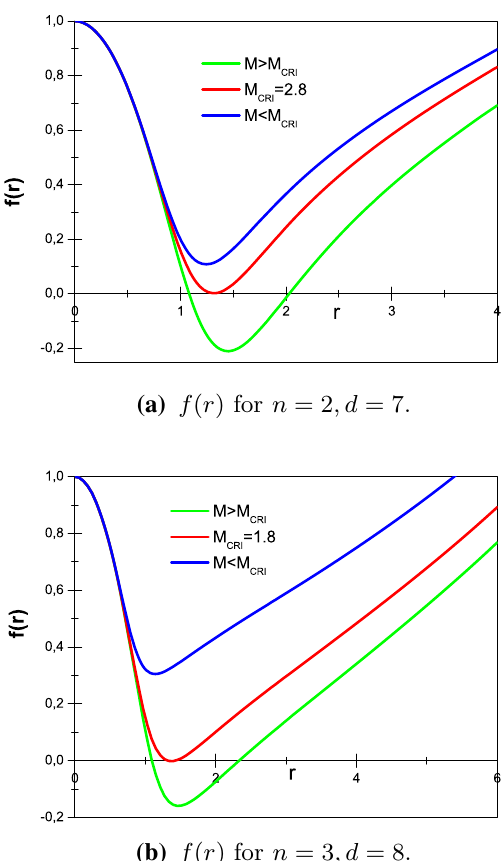
Fig. 2 f ( r ) for second family of solutions with toy values of Q = 1 and l = 8